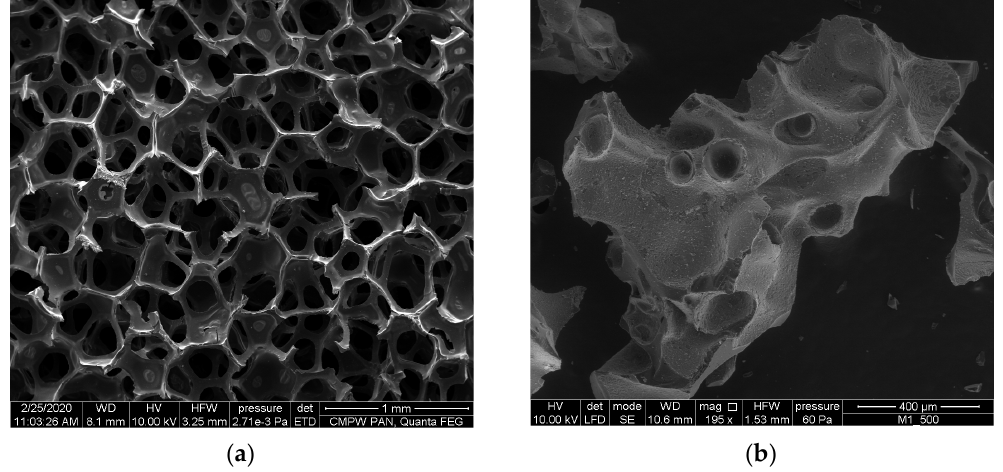
Figure 1. SEM micrographs of open-celled carbon foam with open porosity 60 ppi ( a ) and carbon foam with closed porosity ( b ).